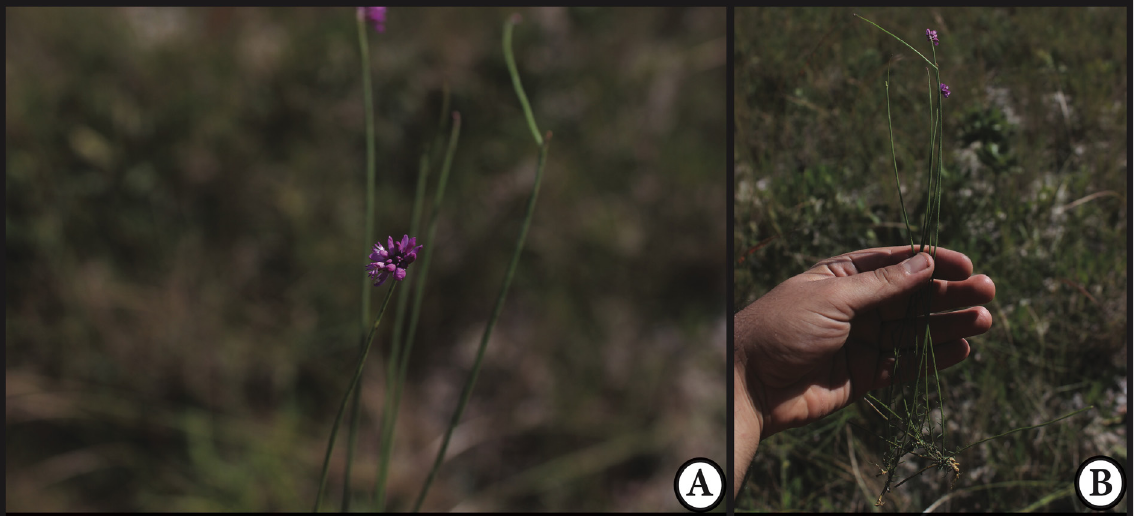
Fig. 5. Polygala tocantinensis J.F.B.Pastore & Antar sp. nov. A . Inflorescence detail. B . Habit. Photos: G.M. Antar, in situ.